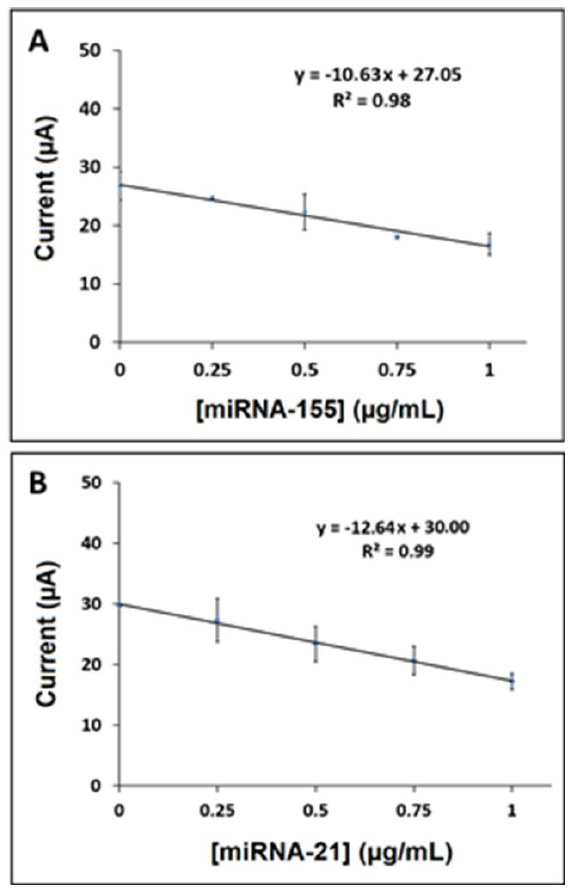
Figure 4. ( A ) Calibration plot for AuNP/RGO-paper electrode obtained after hybridization between Probe-1 and miRNA-155 target with its various concentrations from 0 to 1.0 µg/mL ( n = 3). ( B ) Cal- ibration plot for the same electrode obtained after hybridization between Probe-2 and miRNA-21 target with its various concentrations from 0 to 1.0 µg/mL ( n = 3).